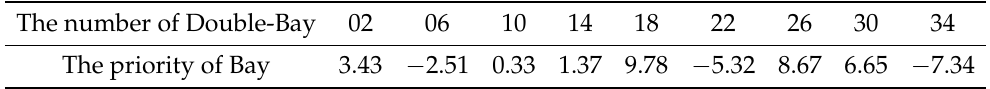
Table 2. Bay position sorting. The number of